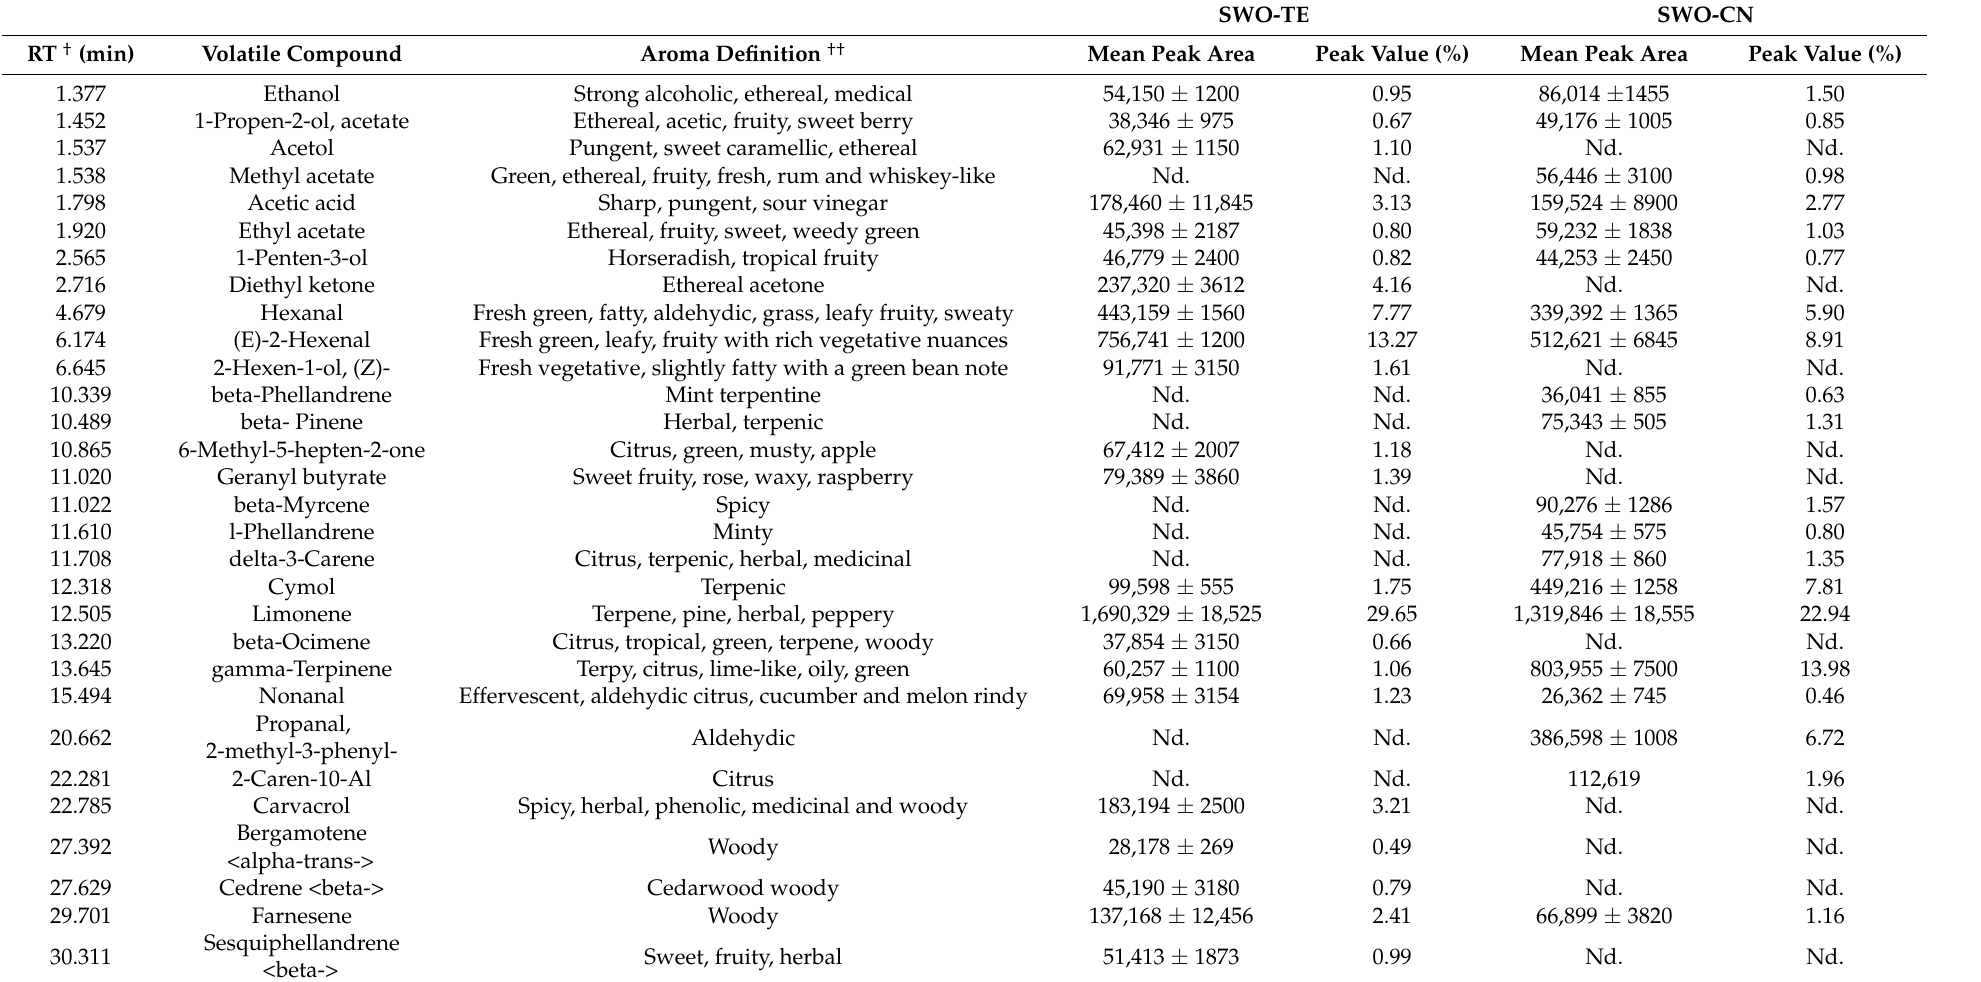
Table 3. The volatile aromatics composition of thyme and cumin-flavored virgin olive oil-sunflower wax